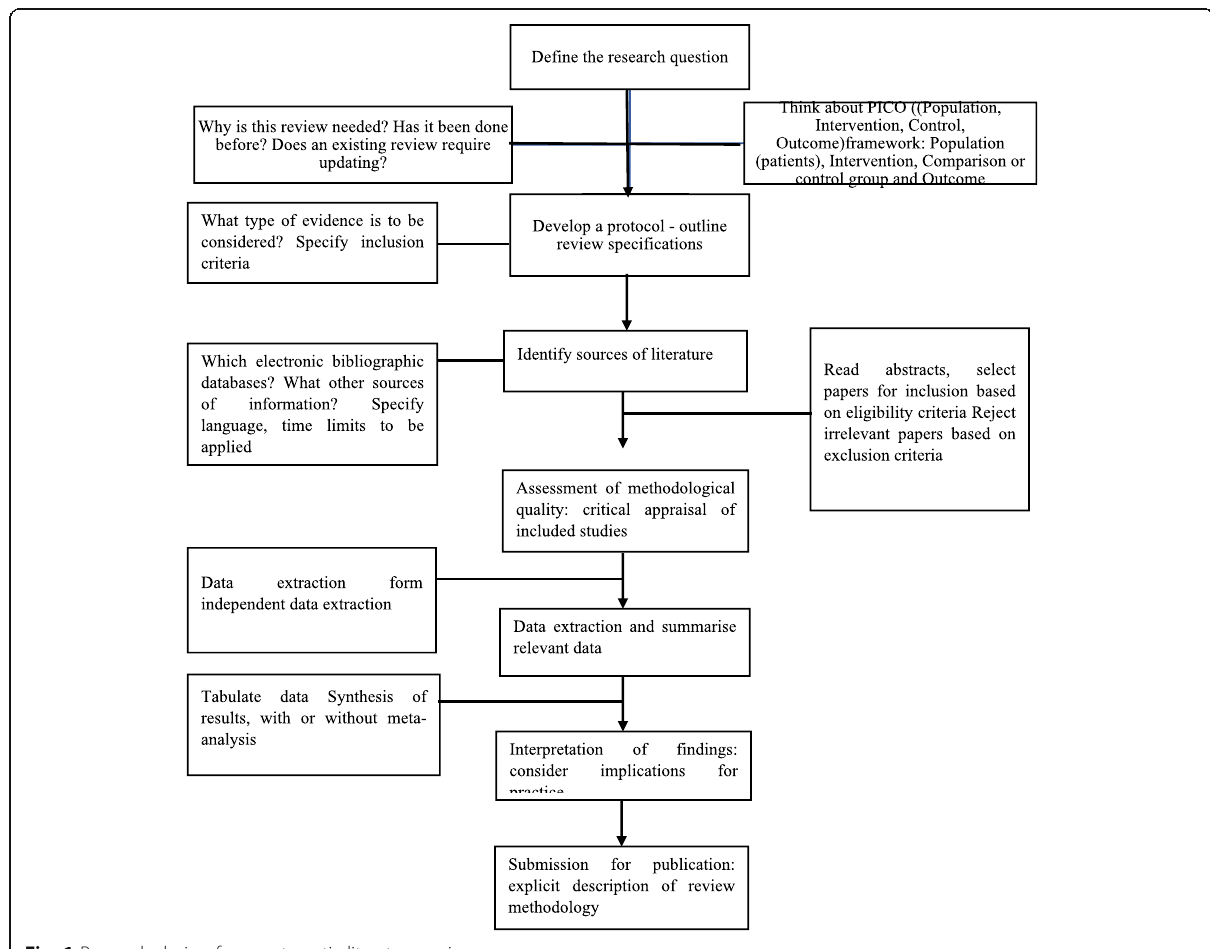
Fig. 1 Research design for a systematic literature